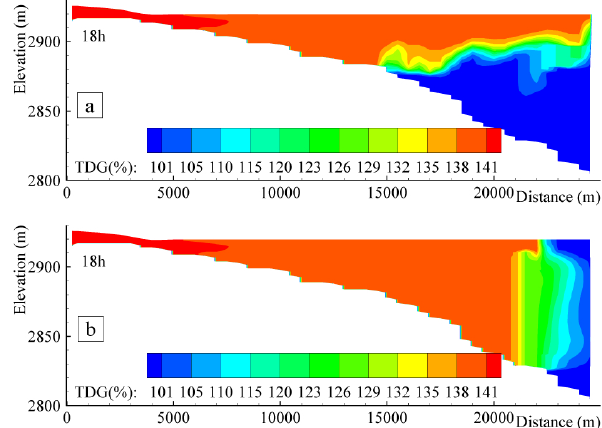
Fig. 15. Comparison of TDG distribution of Case 1 (a) and Case 3 (b) at the moment of accumulated off-time of 24h.